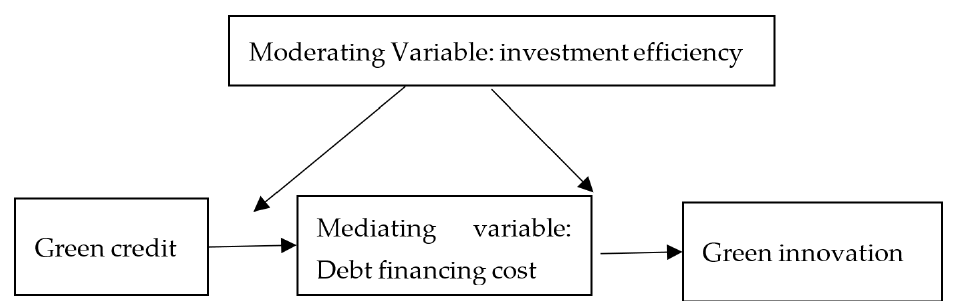
Figure 1. Types of variables in the theoretical model.